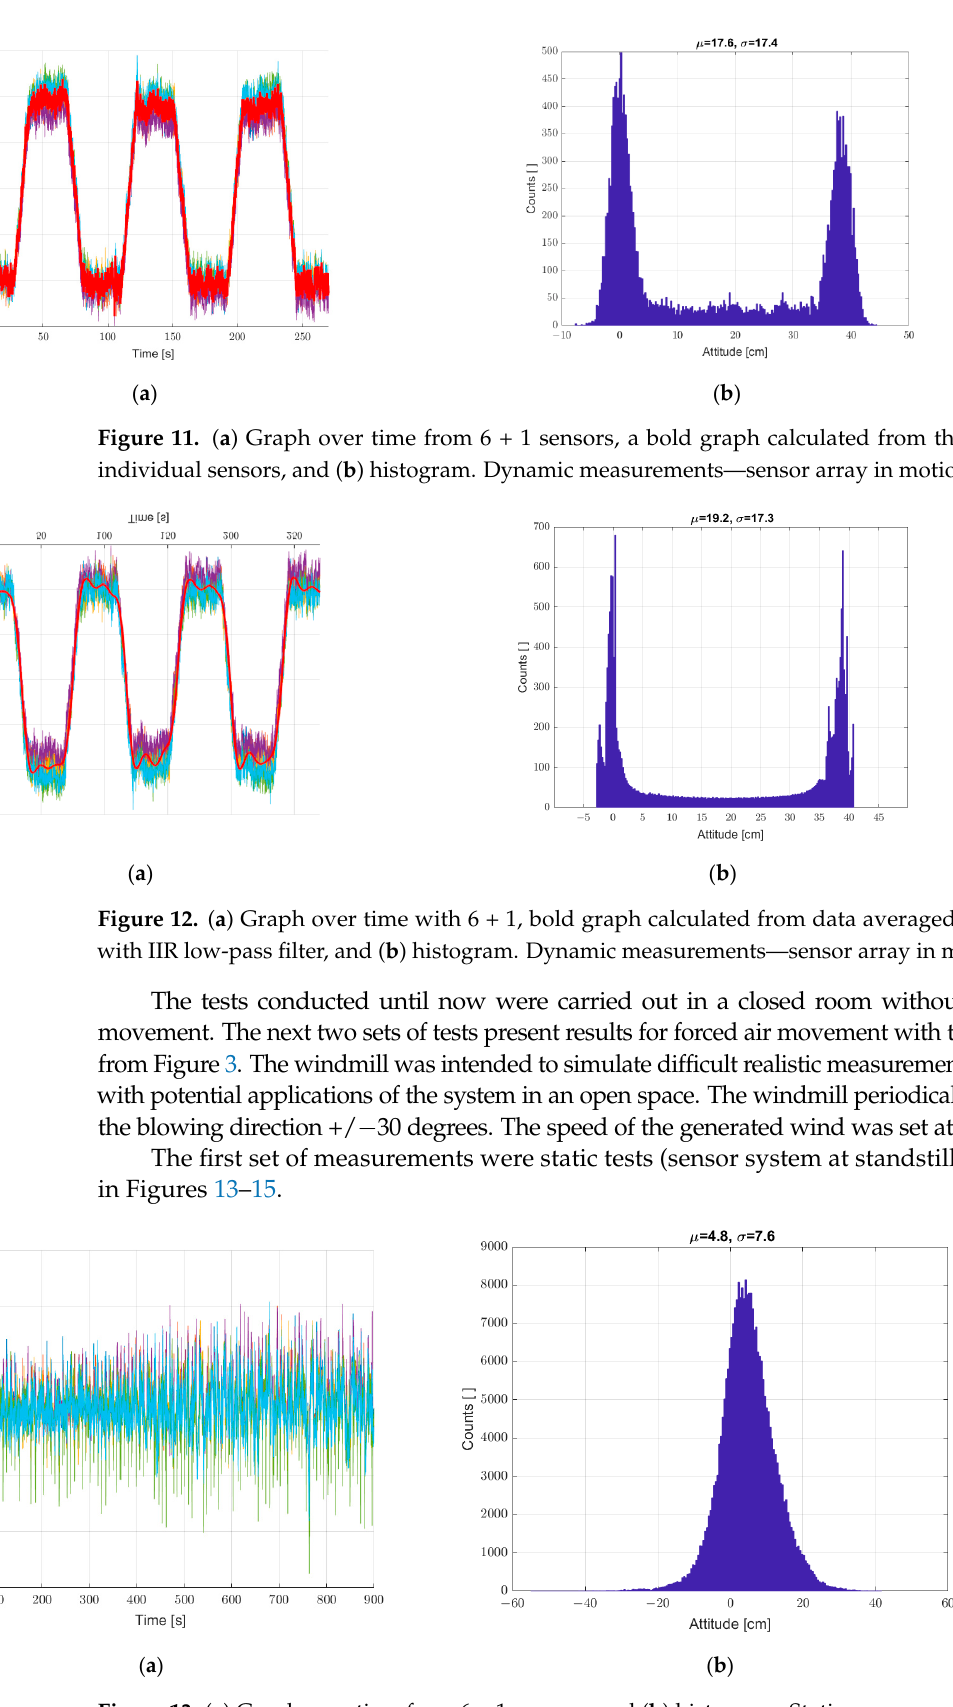
Figure 13. ( a ) Graph over time from 6 + 1 sensors, and ( b ) histogram. Static measurements—sensor array at standstill, with additional variable crosswind gusts.